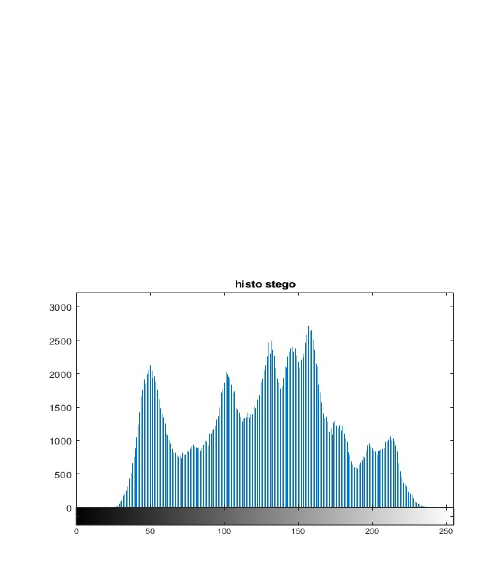
Figure 11: Stego image in our